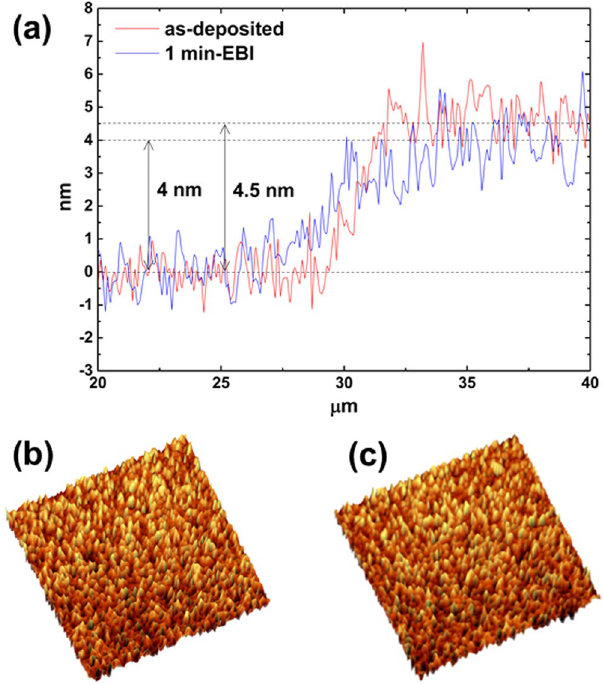
Figure 4. AFM results. ( a ) AFM height profiles of the as-deposited and 1 min EBI-treated sample. AFM images of the ( b ) as-deposited sample and ( c ) 1 min EBI-treated sample in the area of 5 µ m × 5 µ